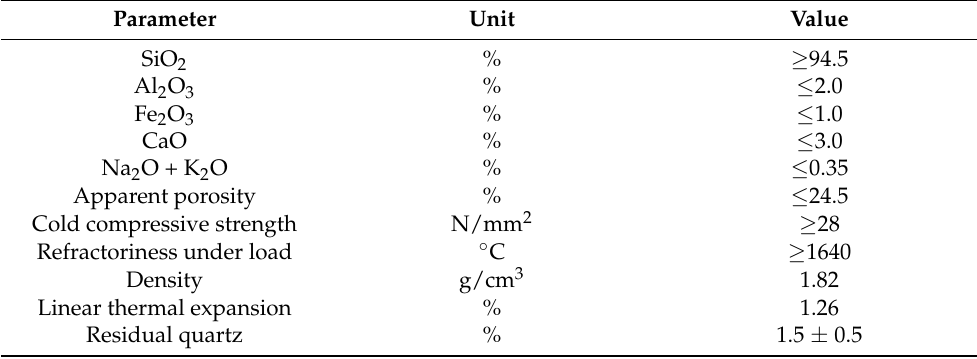
Table 1. Characteristics of silica